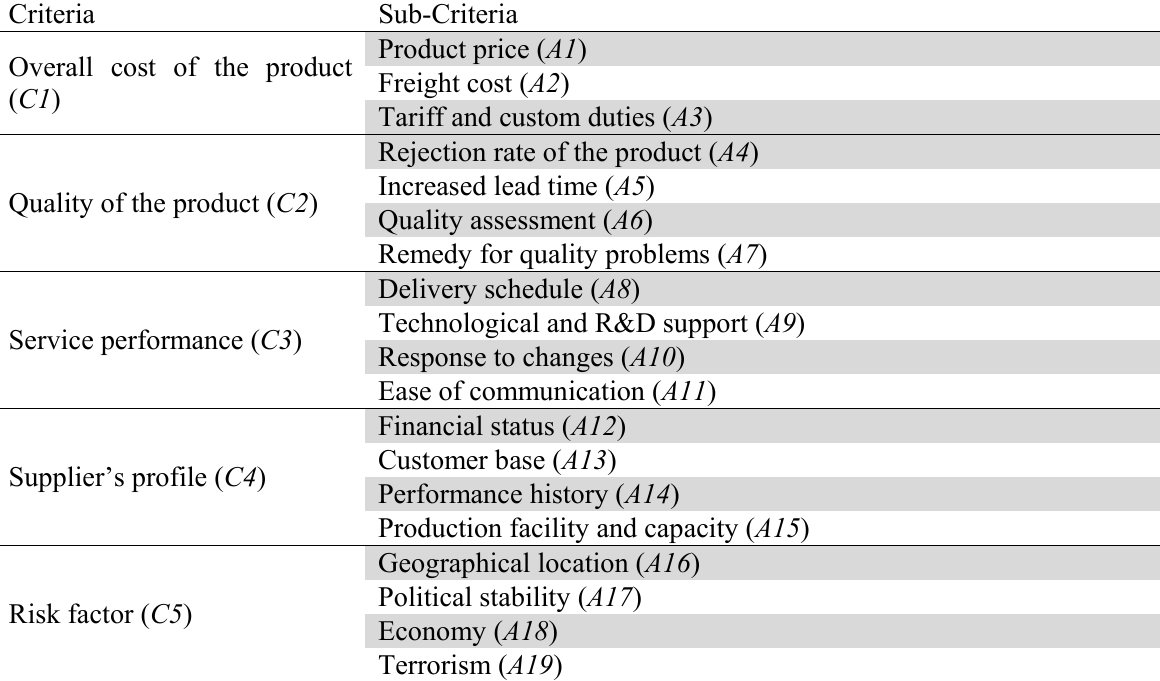
Proposed criteria for global supplier selection decision making Criteria Sub-Criteria Overall cost of the